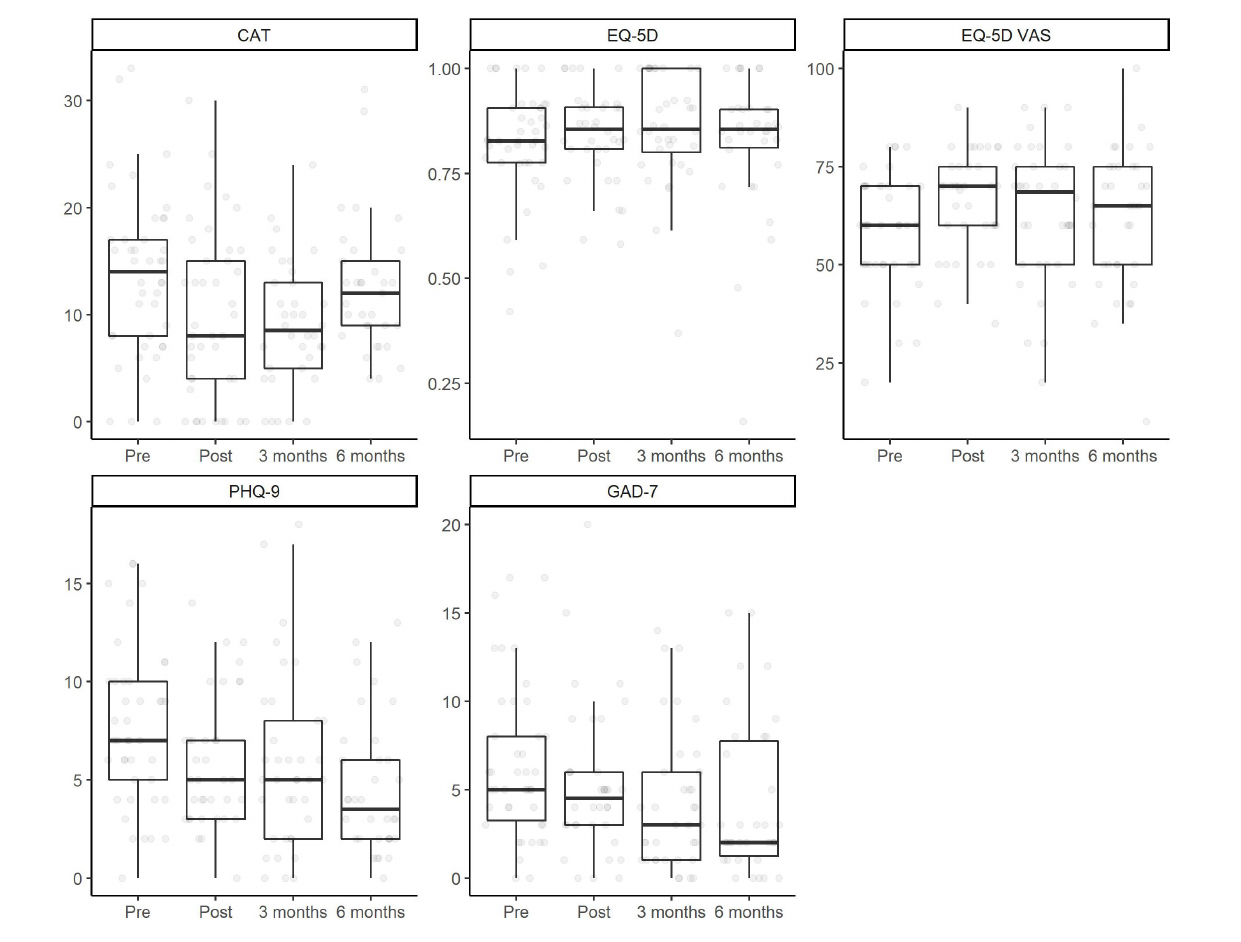
FIGURE 2 | Changes over time in outcome